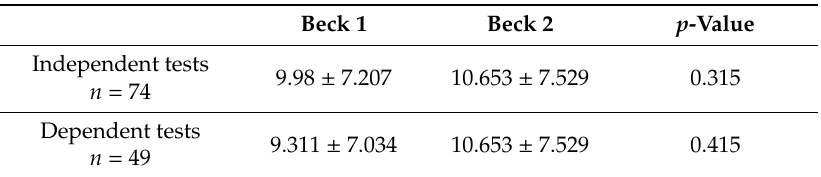
Table 1. Comparison of Beck Depression Inventory-II (BDI-II) score obtained on 7th day (Beck 1) and in follow-up after 6 months (Beck 2).